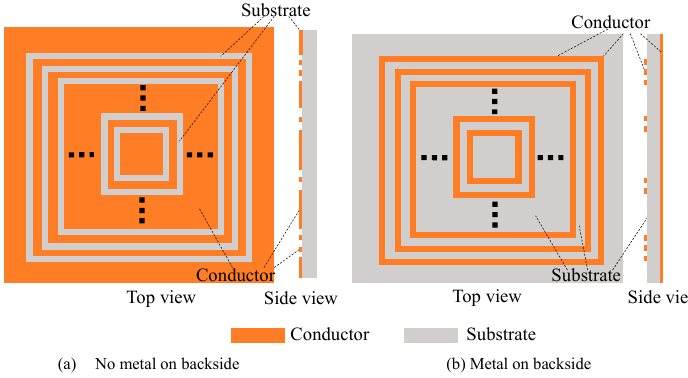
Figure 15. ( a ) Schematic of the designed tag, with top view and cross section, showing slot ring structure; ( b ) The structure proposed by Costa [38,39], using microstrip as resonator, with ground conductor on backside. Table 4. Comparisons of different structures’ characteristic.